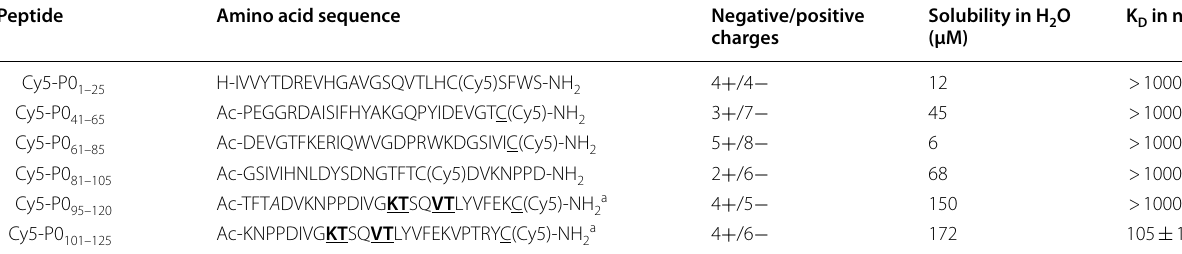
a Italic alanine residue replacing the cysteine from native P0, bolded and underlined residues were implemented via the above-mentioned pseudoproline method [34], underlined cysteines were non-native residues added to the C-terminus